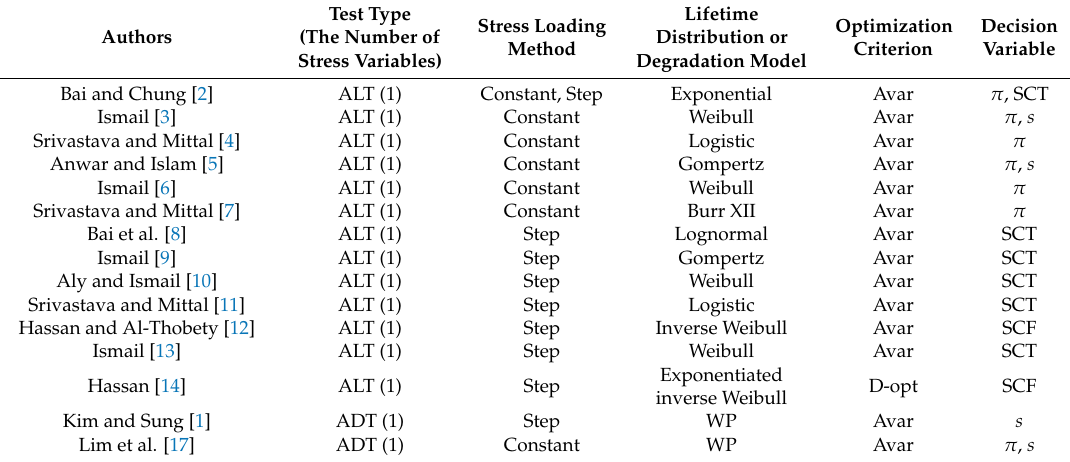
Table 1. The literature on the design of PAT (partially accelerated test) plans